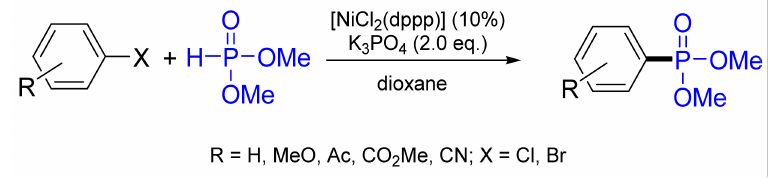
Figure 33. Cross-coupling of dimethyl phosphite with various aryl halides.